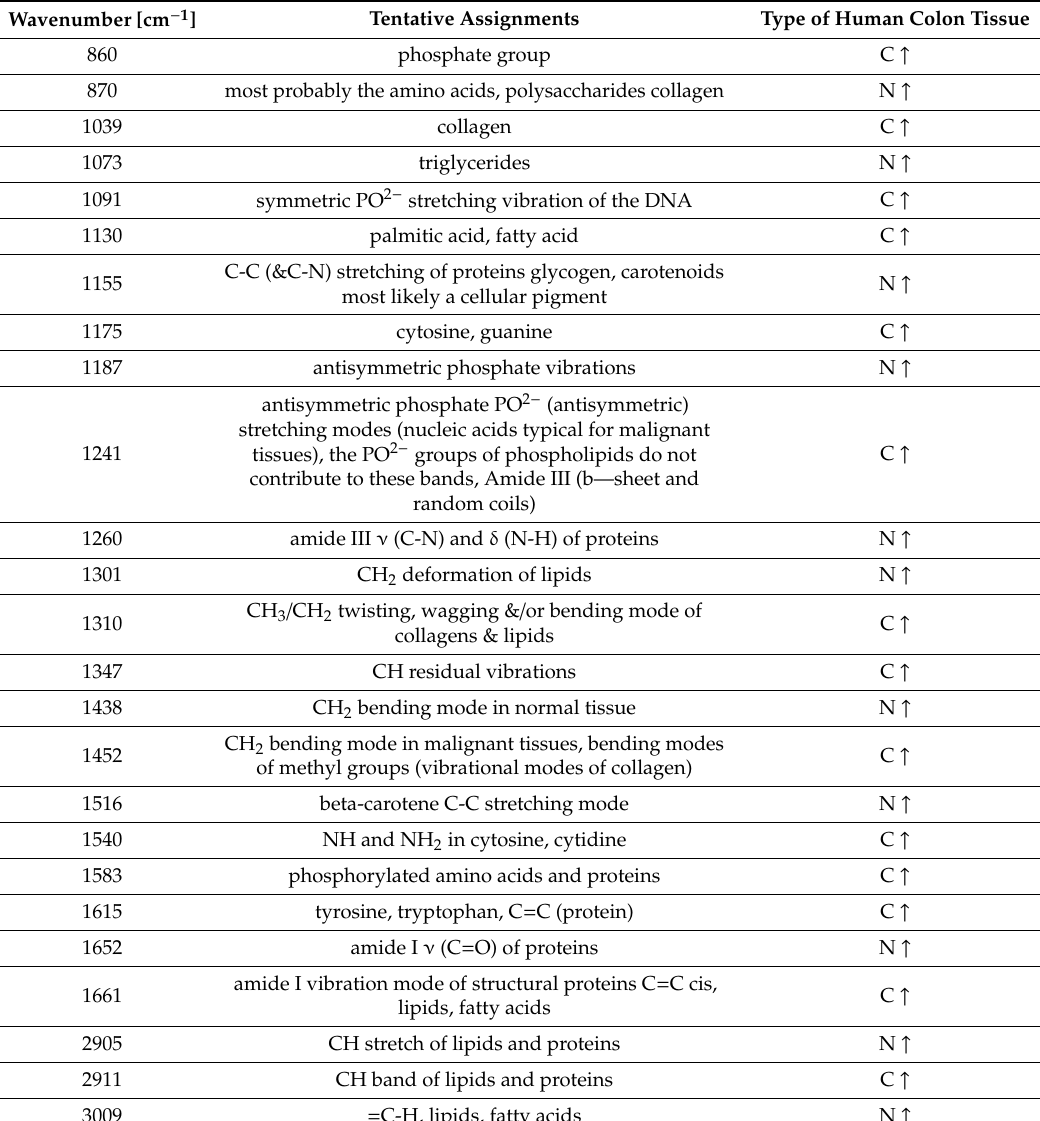
Table 1. The tentative assignments of Raman peaks di ff erentiating the noncancerous and the cancerous tissues of human colon samples, including tendency of concentrations changes of main chemical components [5–19,22–29,31–35]. Abbreviations: C—cancerous tissue, N—noncancerous tissue of the human colon, ↑ —increase in peak